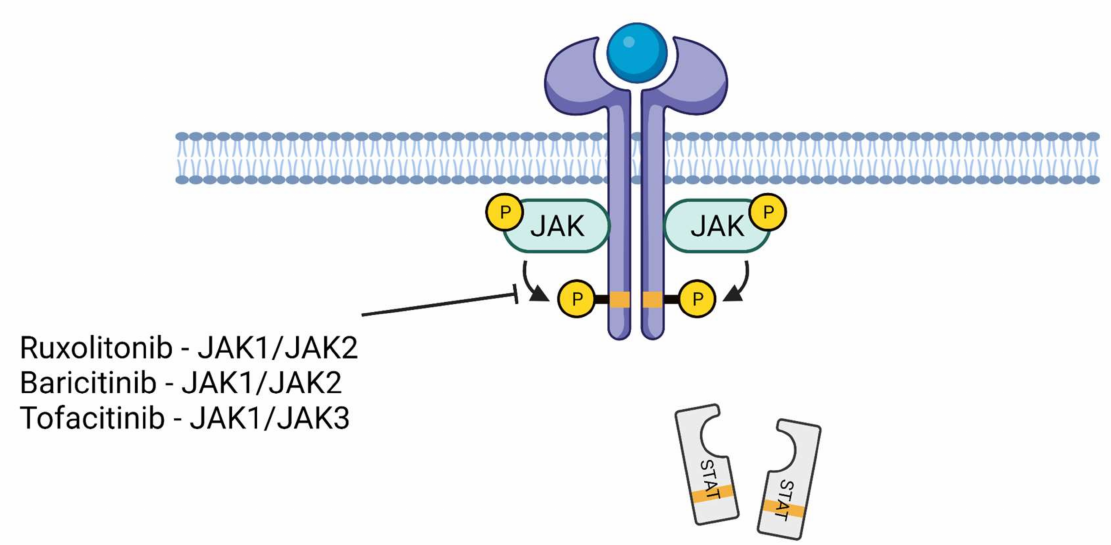
Figure 2. JAK–STAT inhibitors. Ruxolitonib and baricitinib inhibit JAK1/JAK2 while tofacitinib inhibits JAK1/JAK3. This event, in turn, suppresses the phosphorylation of STAT proteins and reduces their nuclear translocation. This phenomenon downregulates the inflammatory